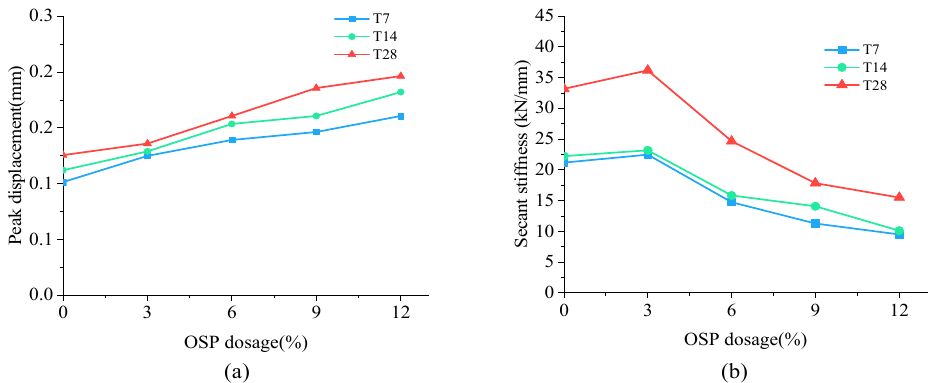
Figure 9. Peak displacement and secant stiffness. ( a ) Peak displacement; ( b ) secant stiffness. Specimens in Group T14 and T28 displayed a similar trend in L-D curves to that of Group T7, but differed in Ks, i.e., for a longer curing time, the Ks of specimens at OSP mass content ranging from 6% to 12% decreased less than that of 0% of OSP mass content. Taking Group T28 as an example, when OSP mass content increased from 6% (M-SW6- T28) to 12% (M-SW12-T28), secant stiffness decreased by 25.7%, 46.2%, and 53.2%, respec- tively compared to 0% of OSP mass content (M-SW0-T28). However, for Group T7, com- pared to OSP mass content of 0% (M-SW0-T7), secant stiffness reduced by 30.4%, 46.7%, and 55.2%, respectively as OSP mass content increased from 6% (M-SW6-T7) to 12% (M- SW12-T7). In addition, curing time similarly affected the relationship between peak dis-